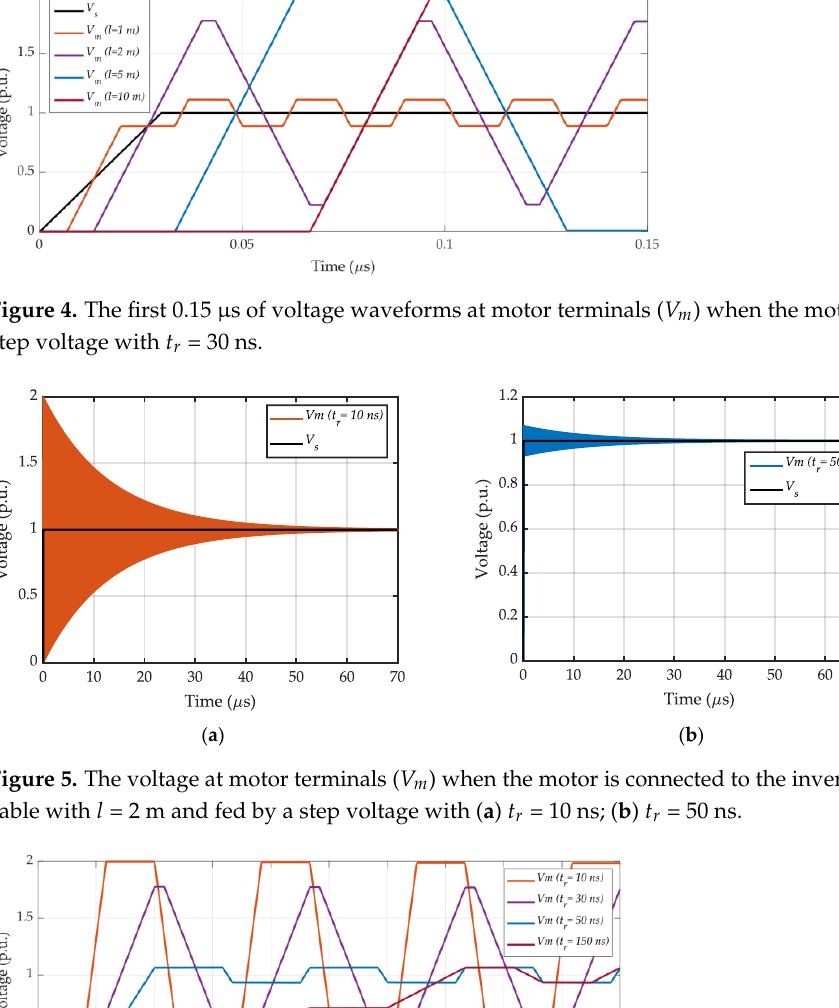
Figure 4. The first 0.15 μs of voltage waveforms at motor terminals ( 𝑉 𝑚 ) when the motor is fed by a step voltage with 𝑡 𝑟 = 30 ns.